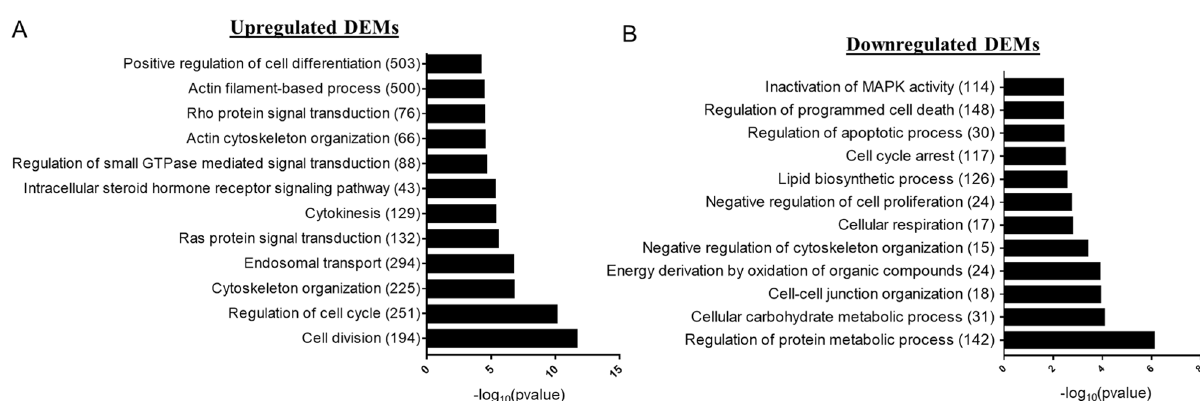
Figure 2. Gene Ontology Enrichment Analysis of Upregulated and Downregulated DEMs. Validated miRNA gene targets for differentially expressed miRNAs were separated into those associated with upregulated DEMs versus downregulated DEMs. GO-BP gene set enrichment analysis was then performed using miRnet built in hypergeometric testing. Significantly enriched (p value < 0.1) pathways of interest are depicted in the bar graphs above for gene targets of either ( A ) significantly upregulated or ( B ) significantly downregulated microRNAs. Numbers in parentheses for each pathway represent to number of identified gene targets associated with the GO-BP pathway